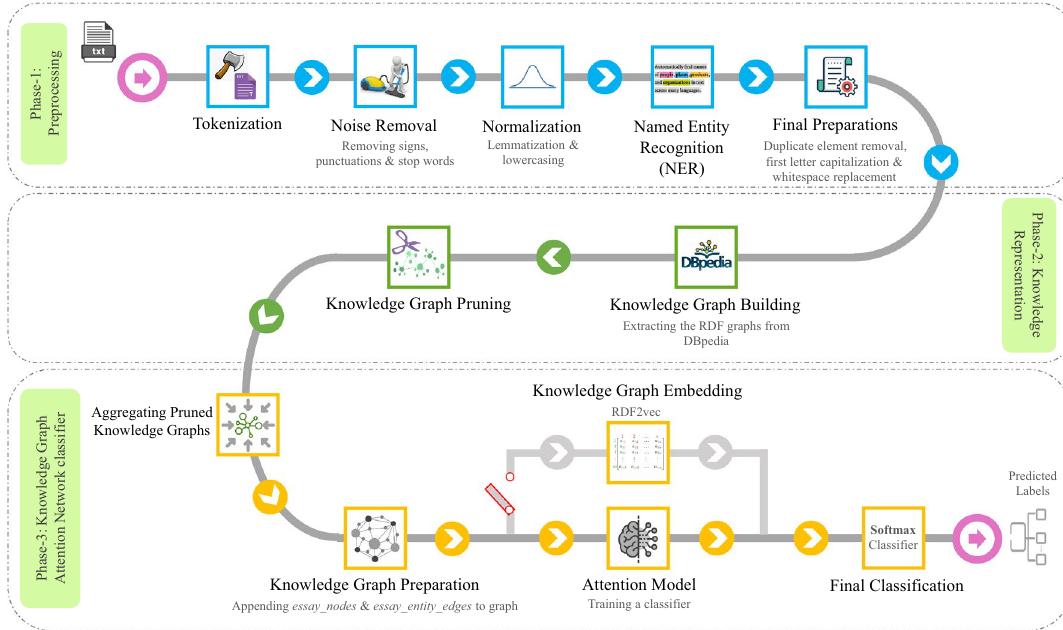
Figure 1. The general architecture of